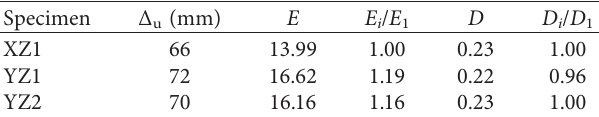
Figure 16: Viscous damping coefficient-displacement curves. Table 5: Energy dissipation ( E ) and equivalent viscous damping coefficient ( D ) under the displacement limit state.